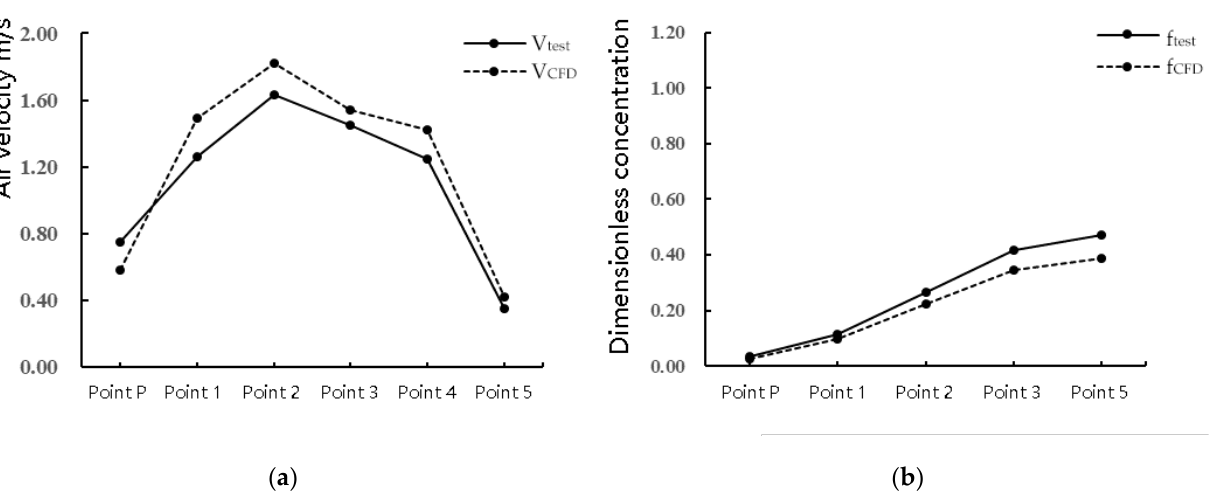
Figure 6. Comparison of measured data and simulation results: ( a ) air velocity; (b) dimensionless concentration.